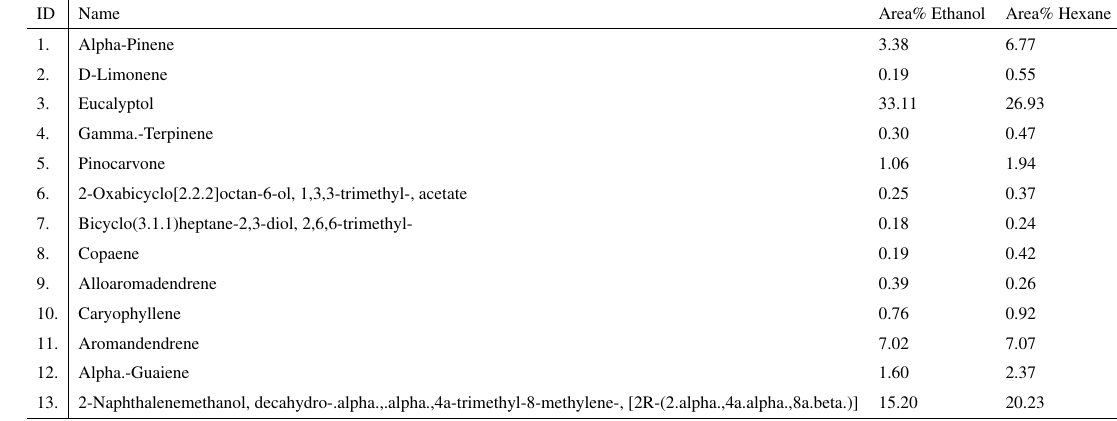
Table 8. Chemical constituent detected appear in the GC-Mass chromatogram in both ethanol and hexane extract of Kafure leaf’s and area percentage of peaks.